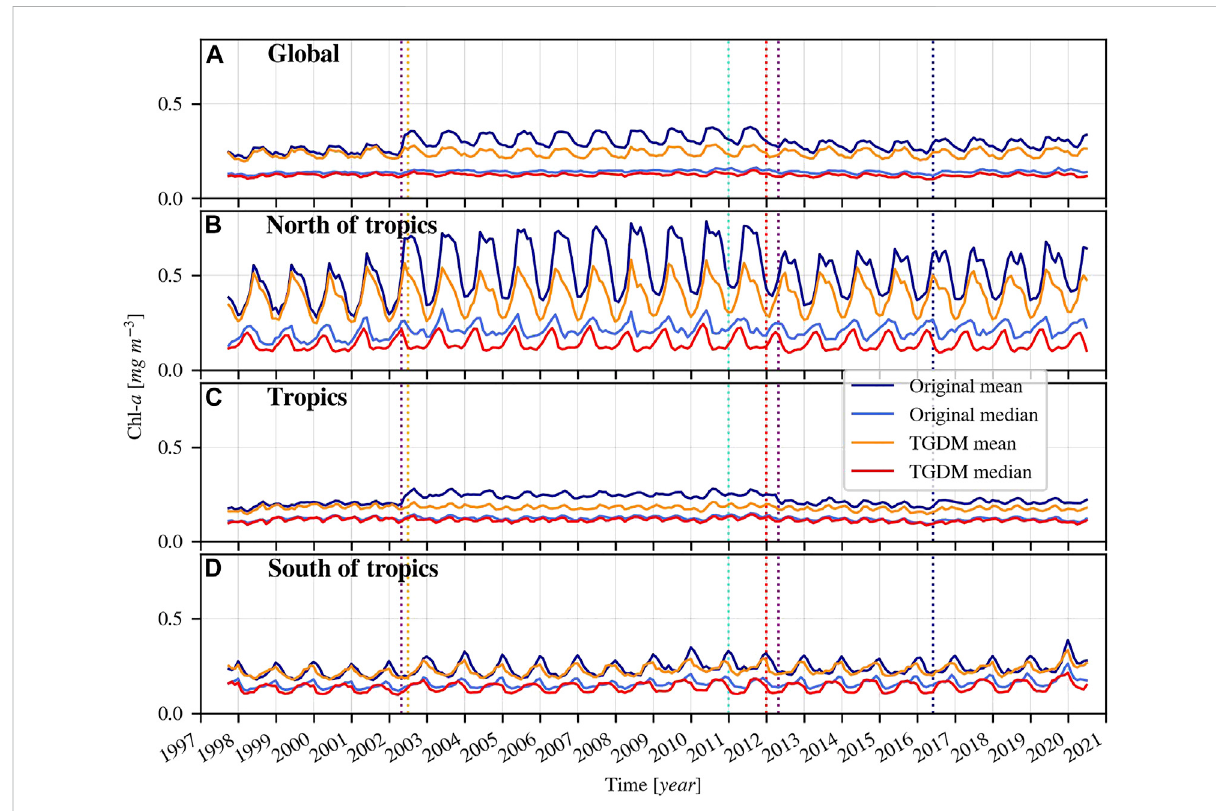
FIGURE 8 Time series of the monthly mean and median Chl- a before and after applying the TGDM: (A) global (B) north of the tropics (C) the tropics, and (D) south of the tropics. Vertical lines indicate changes in sensor contributions (colouring speci fi ed in Figure 1).